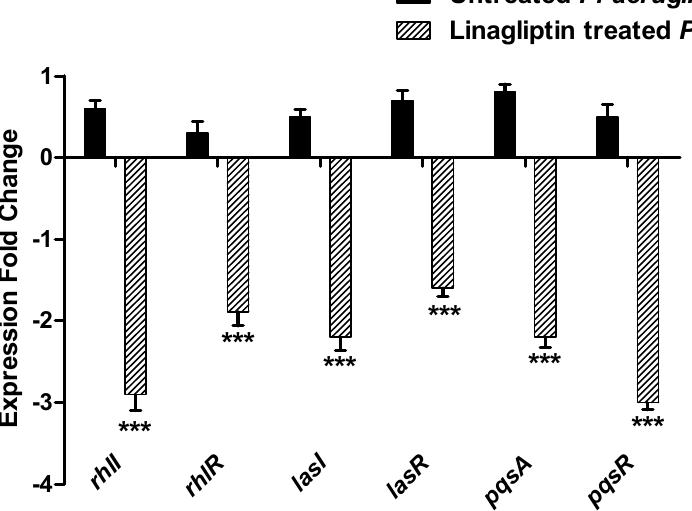
Figure 7. Linagliptin downregulates the expression of P. aeruginosa QS − encoding genes. Linagliptin significantly reduced the expression of P. aeruginosa LasI/R, RhlI/R and Pqs QS systems. *** = p ≤ 0.0001.